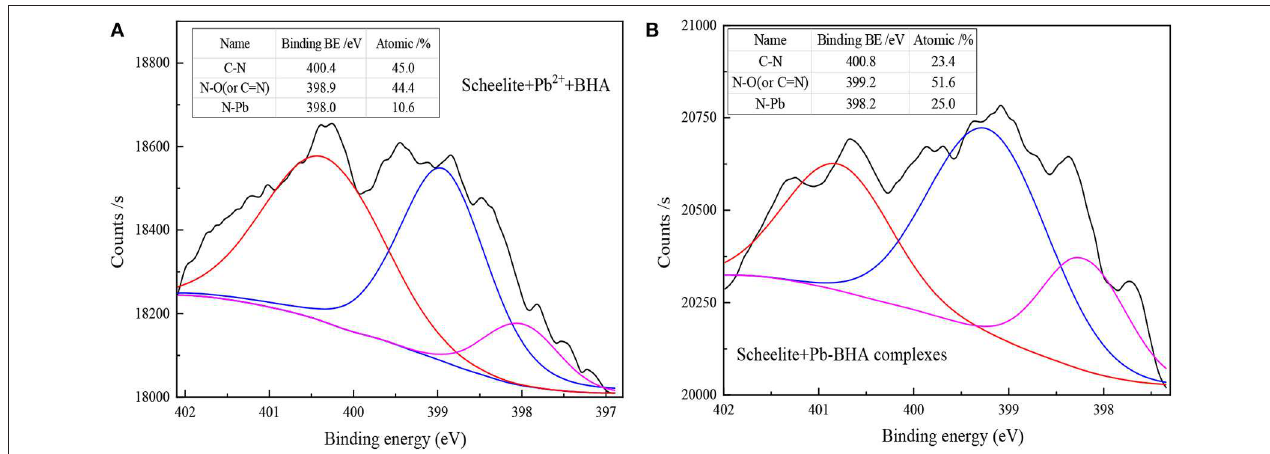
FIGURE 7 | N 1s spectra of scheelite after treatment with different reagents: (A) lead ions and BHA successively adsorbed on scheelite surface; (B) Pb-BHA complexes adsorbed on scheelite surface.